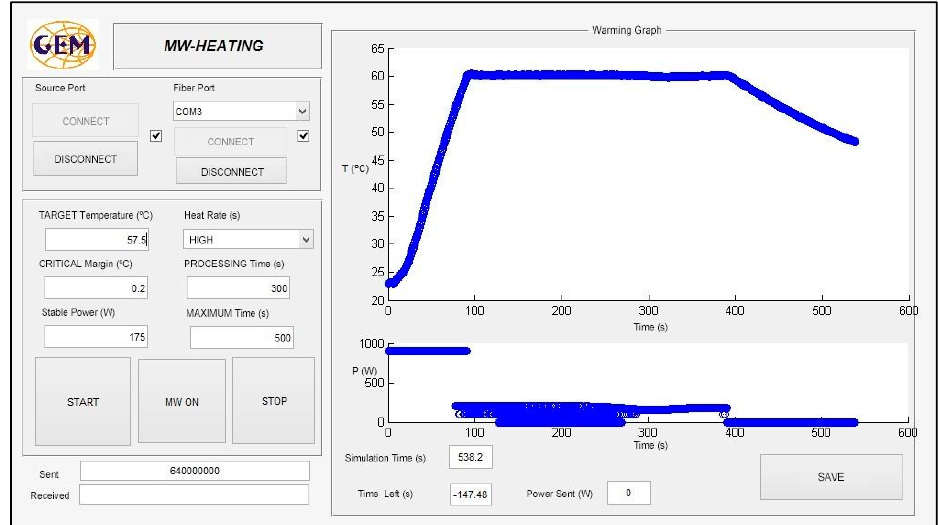
Figure 4. Interface of the developed home-made GUI to control the developed system.